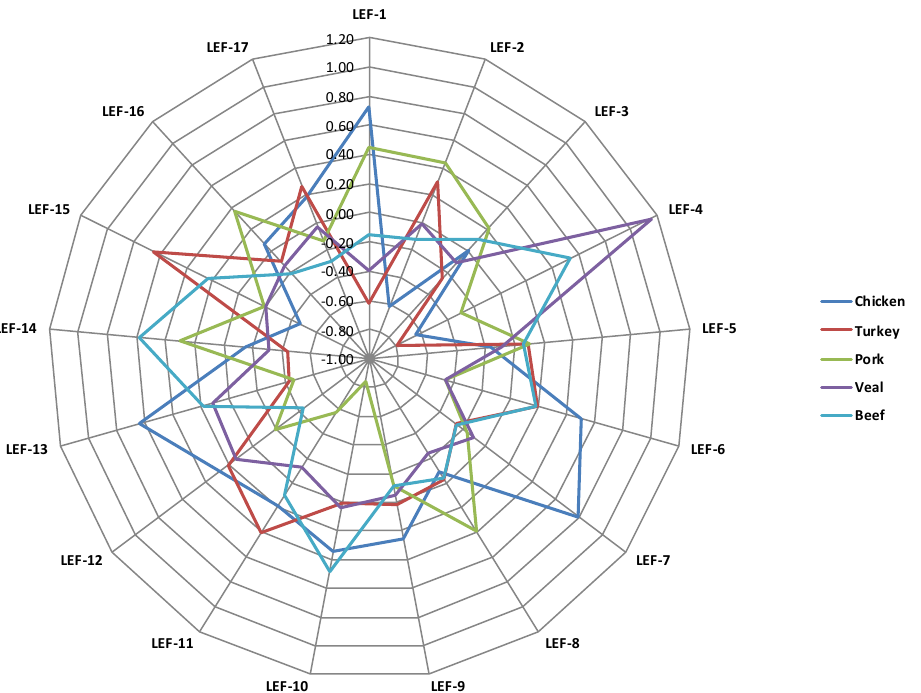
Figure 3. Radar graph plotting the least square means of latent explanatory factor (LEF) scores of meat VOCs according to different animal species.